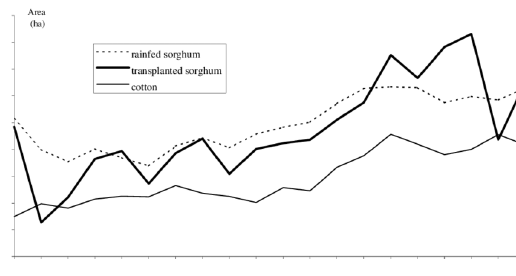
Figure 6: Evolution of the main Crops in the Cotton Belt of